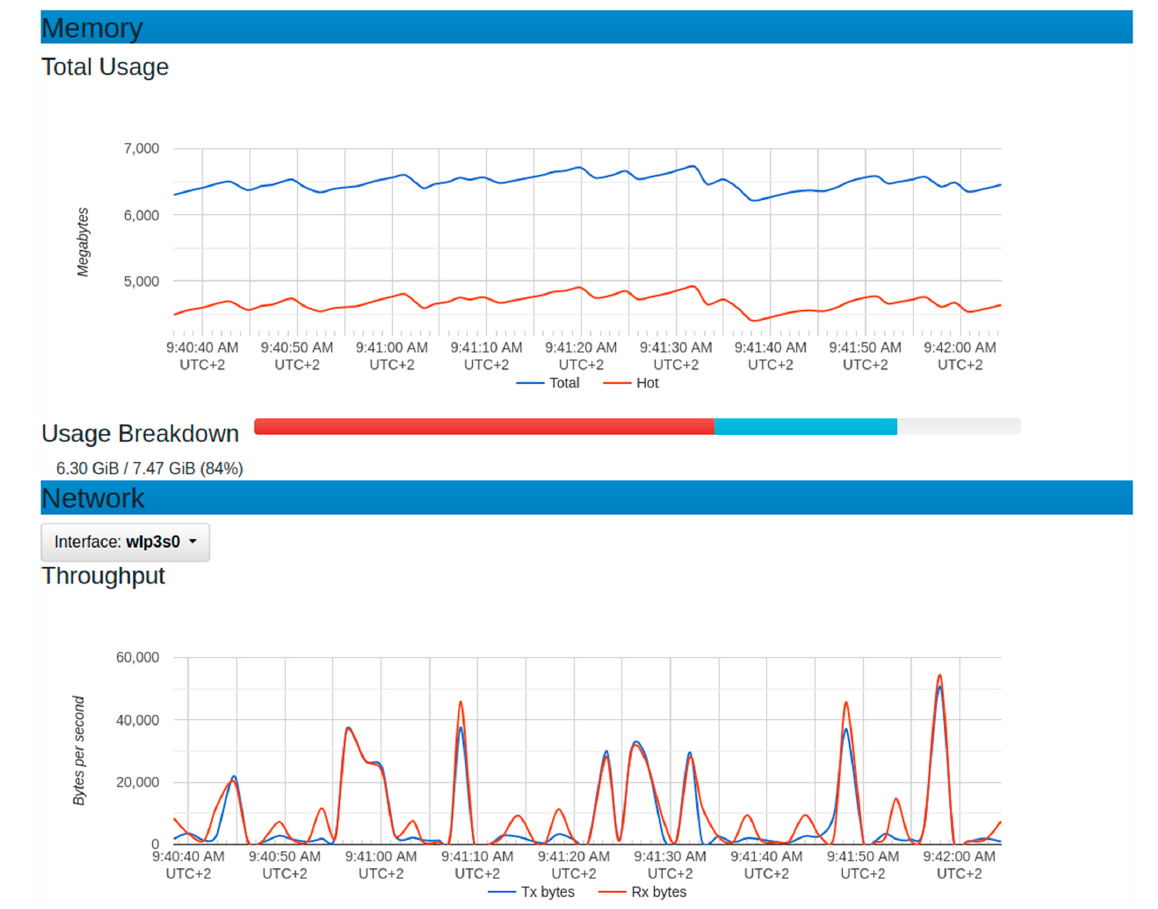
Figure 16. Resource usage for memory and throughput with 10,000 generated sensor requests.